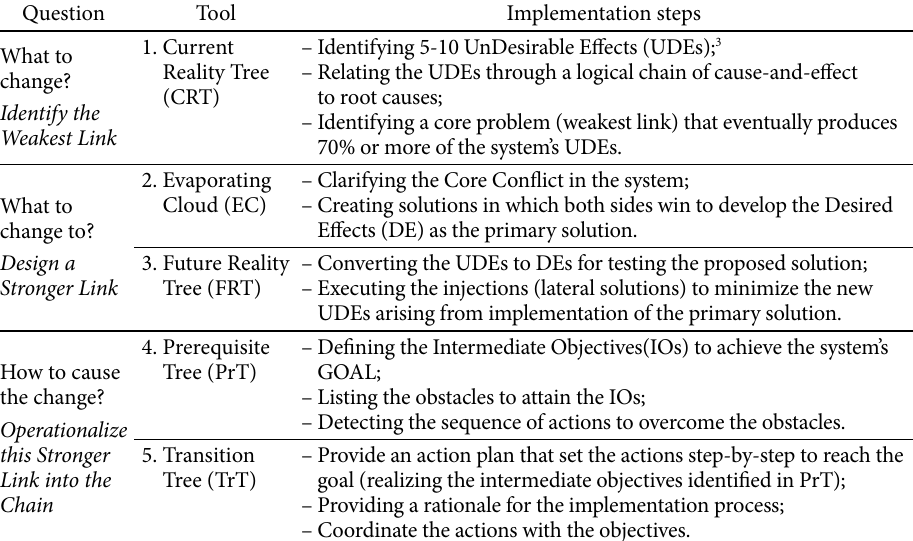
Table 2. TP tools (Mabin 1999; Choe, Herman 2004) 3